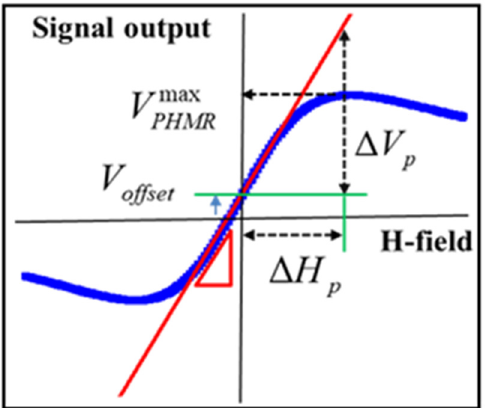
Figure 1. Schematic representation of sensitivity estimation from a PHMR signal profile. The peak field, ∆ Hp is governed by the internal field of the sensing layer of NiFe in multi-layer structure. In exchange biased sensing layer with antiferromagnetic layer,